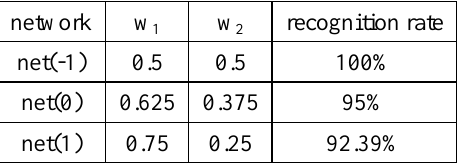
Table 3 The recognition rates of three networks under respective optimal weight coefficients